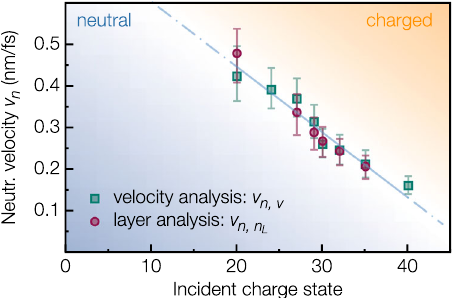
Fig. 4 Neutralisation length of highly charged Xe ions. The neutralisation length n L in number of graphene layers is extracted from fi ts for different n projectile velocities and charge states (Xe 20 + : blue circles, Xe 27 + : pink stars, Xe 30 + : red squares and Xe 35 + : yellow triangles) as explained in Supplementary Information Fig. S2. We fi nd that the number of layers needed for highly charged ion neutralisation depends linearly on the projectile energy. The error stems from the difference in fi tting parameters considering the extreme cases of errors for the data presented in Supplementary Information Fig. S2.